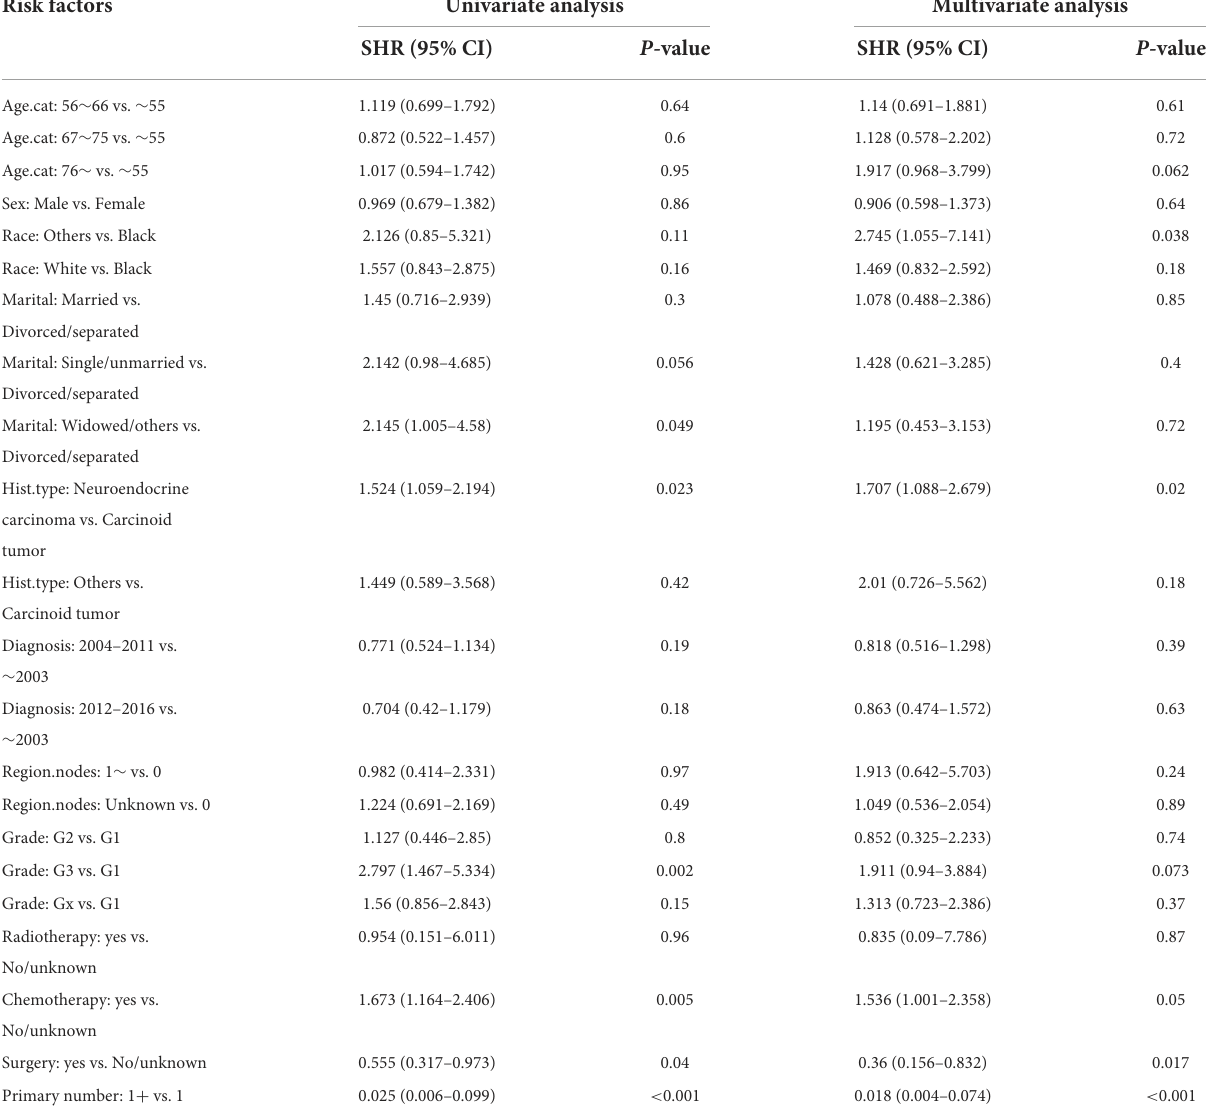
TABLE 4 Univariate and multivariate Fine-Gray analysis of factors for cumulative probabilities of PHNET-specific death in the training set. Risk